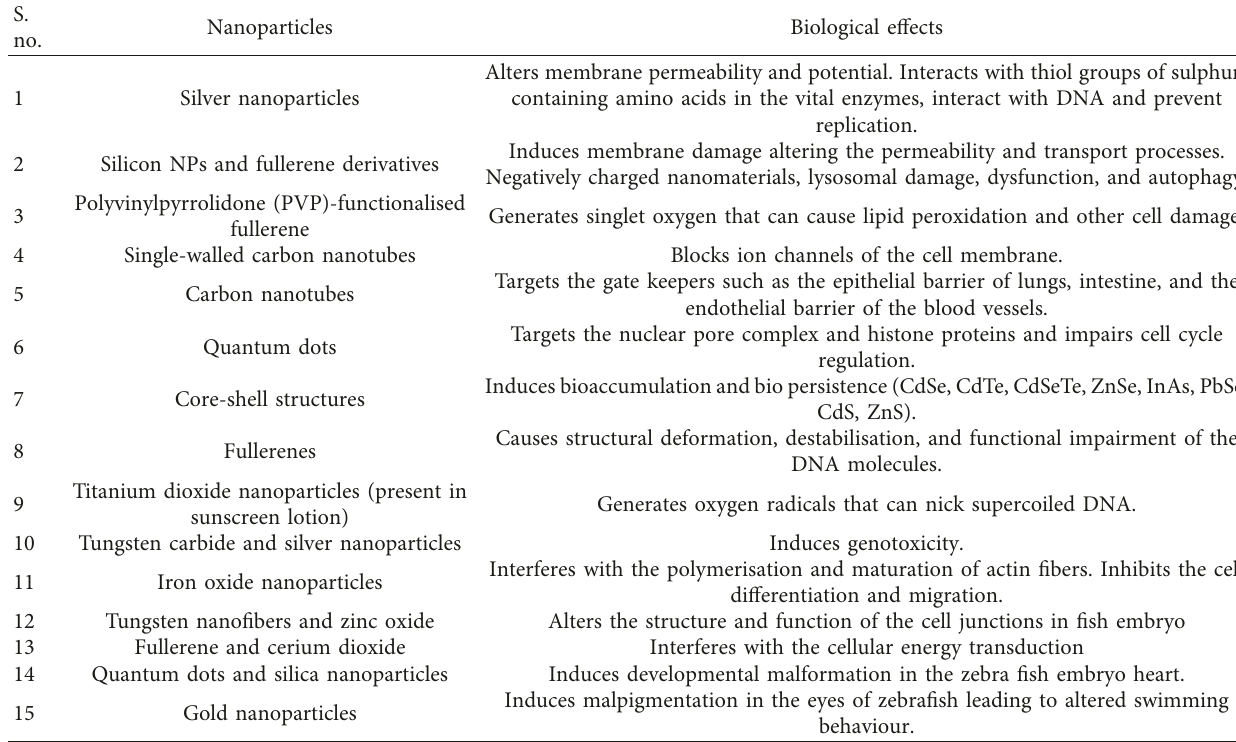
Table 2: Biological effects of various nanoparticles on aquatic